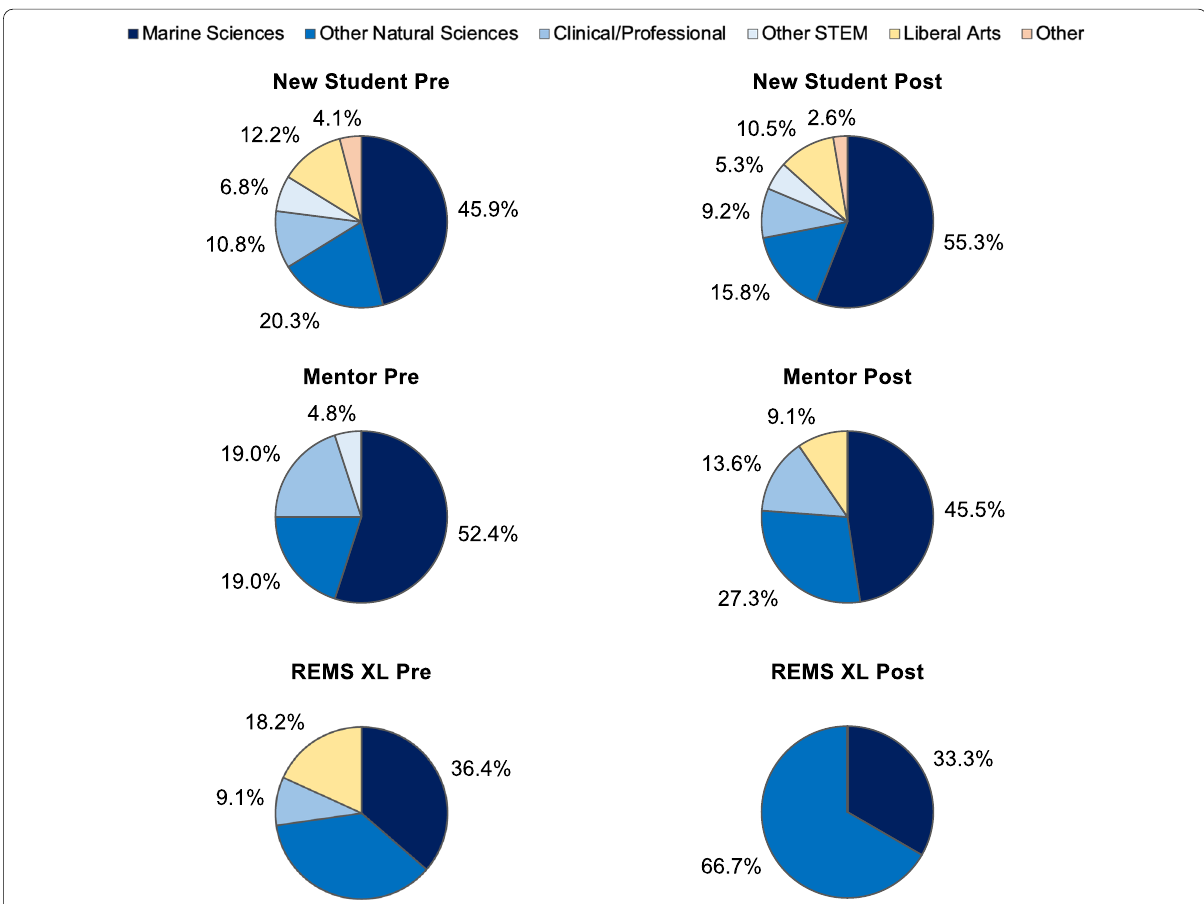
Fig. 17 Interest: Pre- and post-program student intended/reported university major. New Student ( N student ( N 12) responses. “Marine Sciences” includes Marine Biology, Oceanography, and other majors that are related to ocean sciences. “Clinical/ = Professional” majors include pre-med and pre-vet tracks. “Other Natural Sciences” includes life sciences (e.g., biology, botany) and physical sciences (e.g., physics, chemistry) that do not explicitly relate to ocean